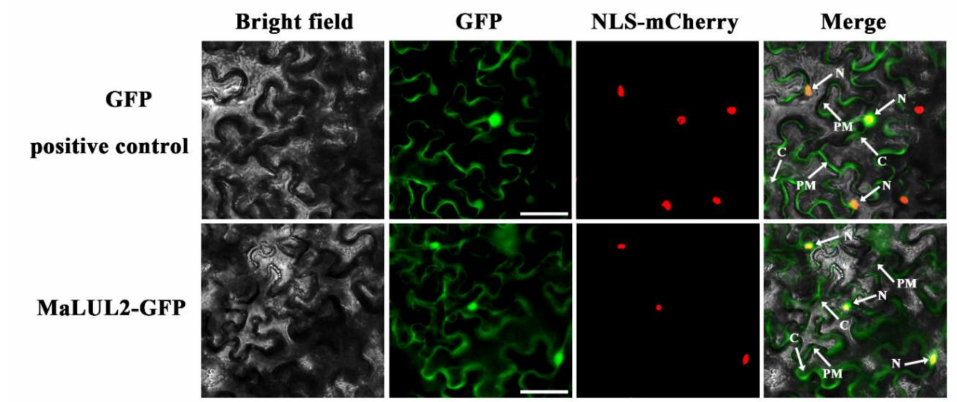
Figure 4. Subcellular localization of MaLUL2 in epidermal cells of Nicotiana benthamiana leaves. A plasmid harboring GFP or MaLUL2 − GFP was transformed into Nicotiana benthamiana leaves by Agrobacterium tumefaciens strain EHA105. GFP signals were observed with a fluorescence microscope after 2 days of infiltration. The NLS − mCherry was included in each transfection to serve as a control for successful transfection as well as for nuclear localization. Cytoplasm (C), plasma membrane (PM), and nucleus (N) are indicated by arrows. Bars, 50 µ